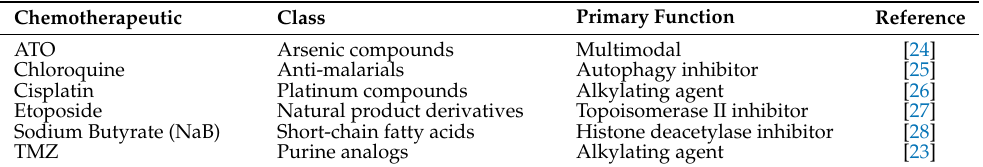
Table 2. Classes and functions of chemotherapeutic drugs that have synergistic anti-GBM potential in combination with